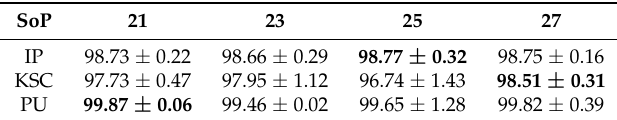
Table 2. Overall Accuracy of each dataset based on various patch sizes (SoP). The number in bold is the best Overall Accuracy.